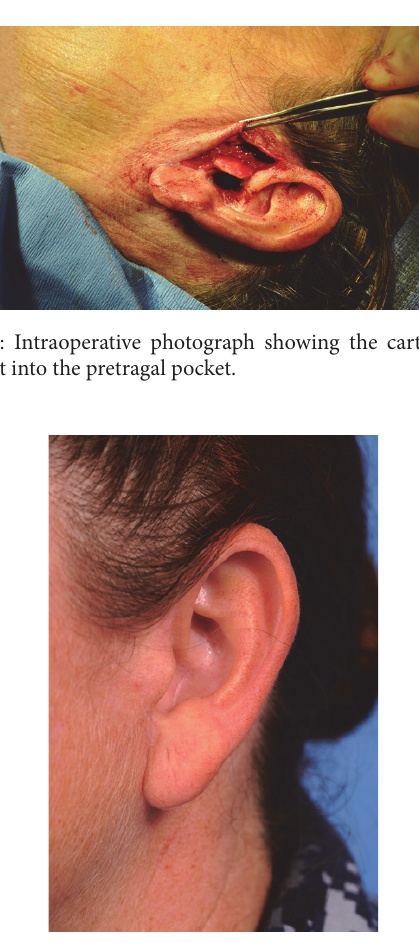
Figure 4: Postoperative photograph of the patient after 9